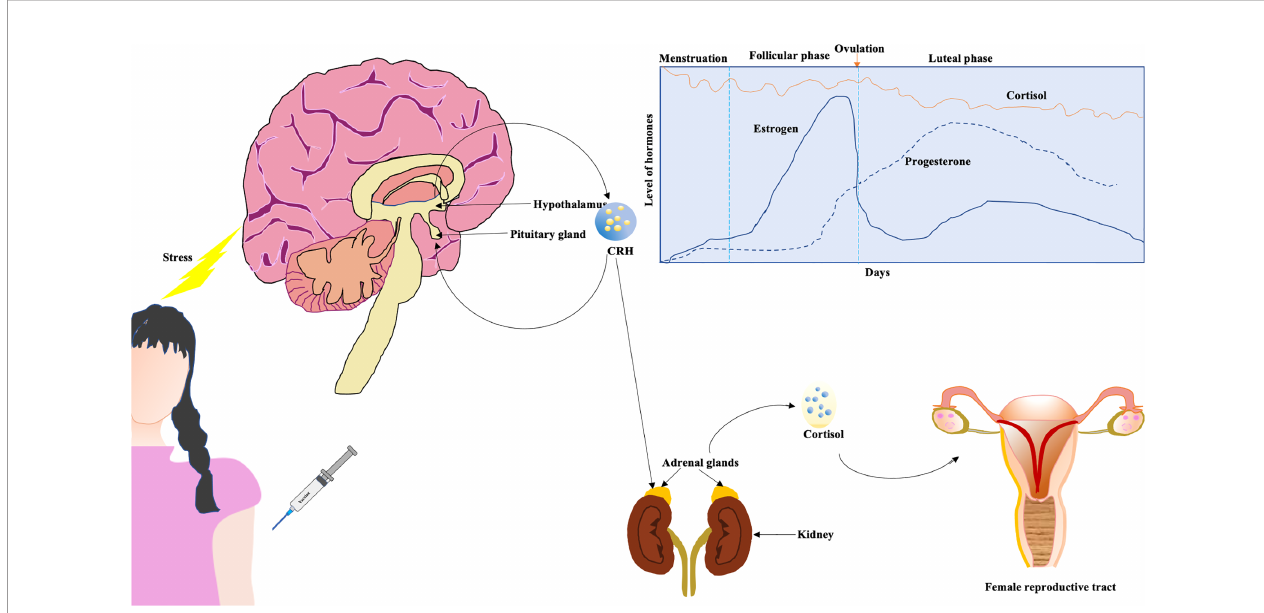
FIGURE 2 | Cortisol affecting female reproductive tract. The hypothalamus-pituitary-adrenal (HPA) axis might be affected due to the imposed stress of vaccination (a higher dose). The cortisol affects female reproductive tract. Generally, circulating levels of cortisol are higher during follicular phase in contrast to luteal phase (graphical representation)